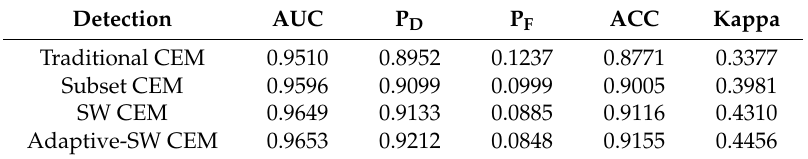
Table 5. Detection results of traditional CEM and our proposed CEMs in the image of Region 2.